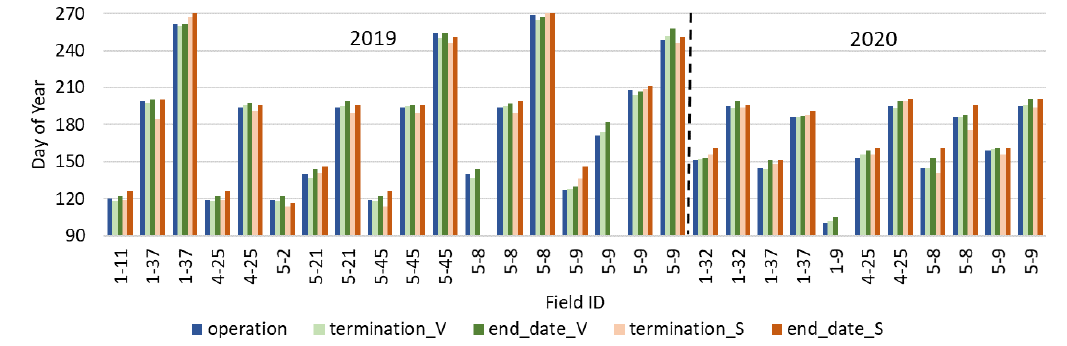
Figure 13. The recorded harvest / termination operation dates, the detected termination dates, and the ending dates (the last day used in the simulation) from VEN µ S (_V) and Sentinel-2 (_S) in the daily near-real-time simulation for 29 harvests ( x -axis) in 2019 and 2020. The x -axis shows the field name of each harvest. The dashed line separates harvests in 2019 and 2020.